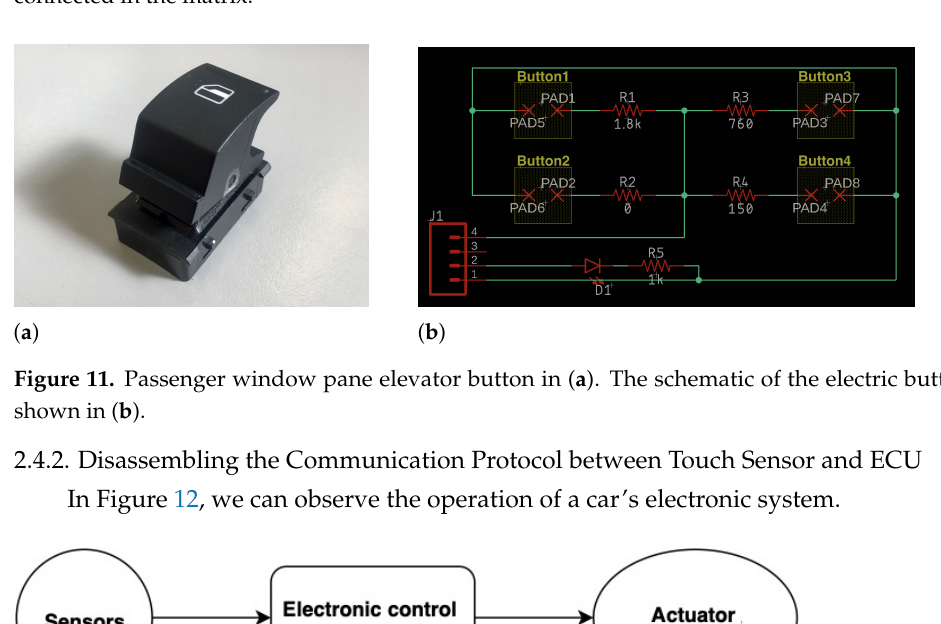
Figure 10. Illustration of the scanning and reading algorithm performed to the buttons that are connected in the matrix.